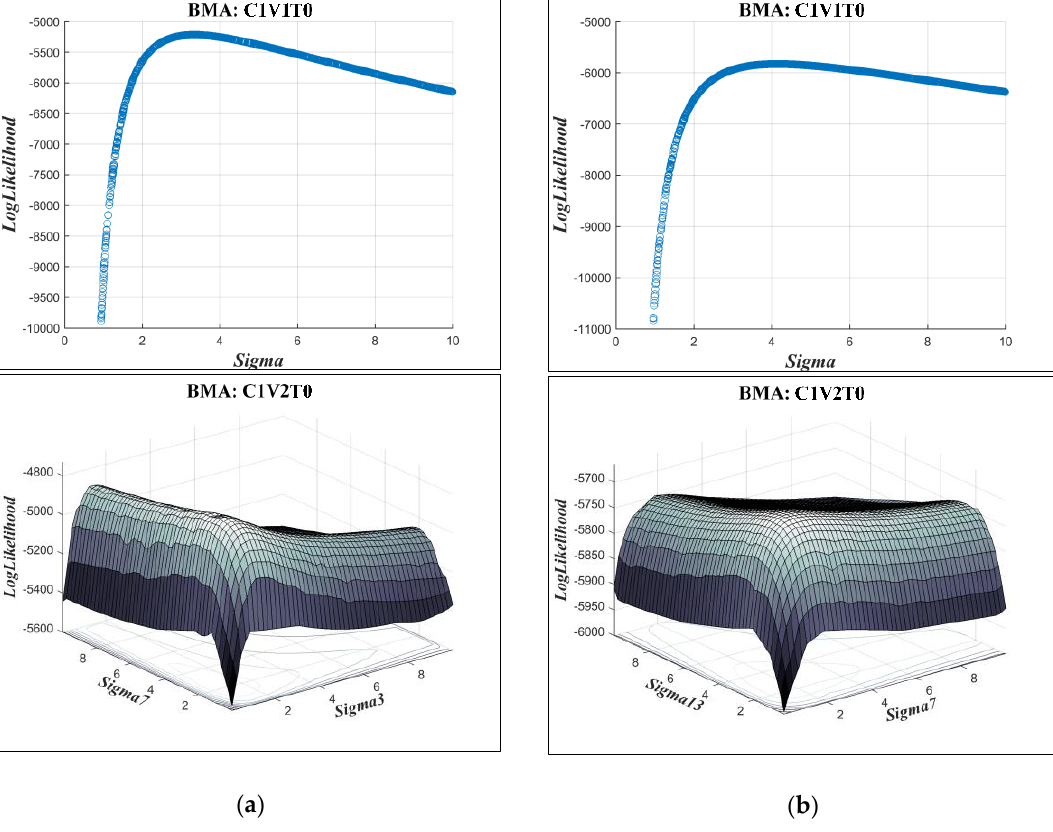
Figure 13. The changes of the objective function regarding the most sensitive parameter(s) for the C1V1T0 and C1V2T0 BMA variants in both the ( a ) Big East River and ( b ) Black River